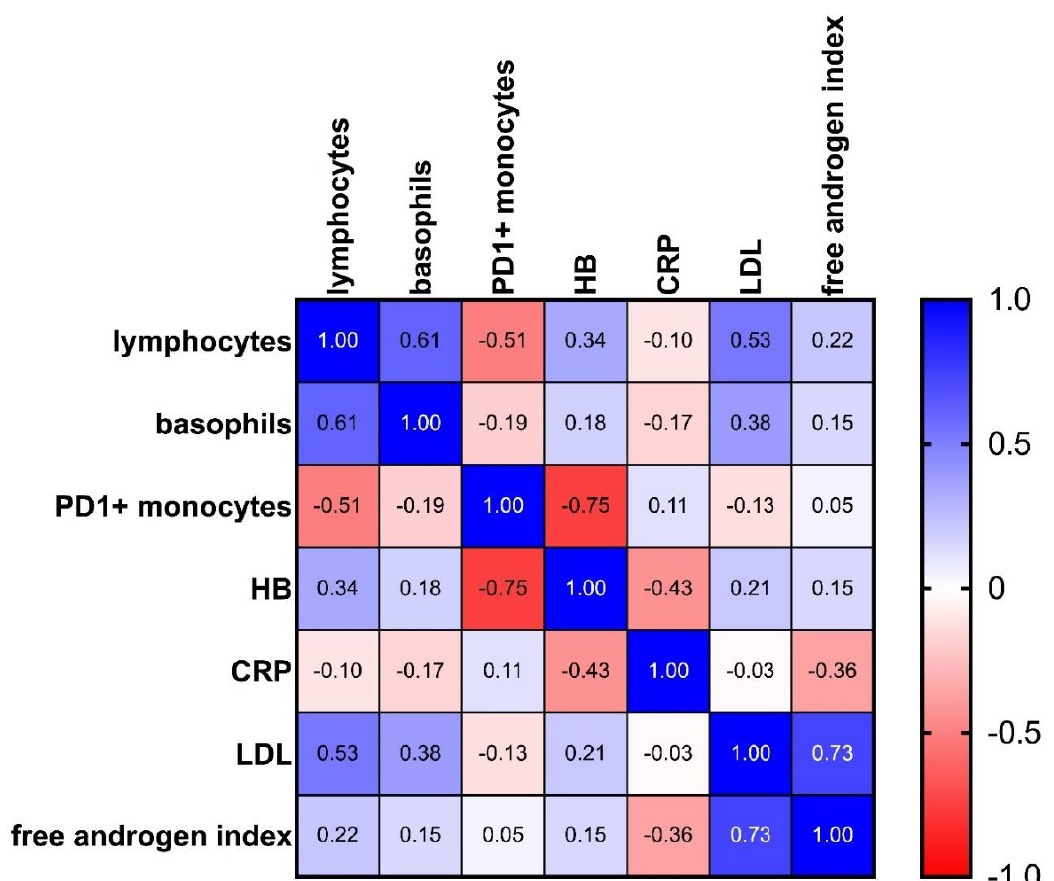
Figure 5. Heatmap showing multiple correlation analysis for the target analytes: 1.0 (blue) stands for a perfect positive correlation; 0 (white) means no correlation, and − 1.0 (red) stands for a perfect negative correlation. Values between 0 and 1 indicate analytes increasing or decreasing together; values between 0 and − 1 indicate that one analyte increases as the other decreases (see also Supplemental Data S4).